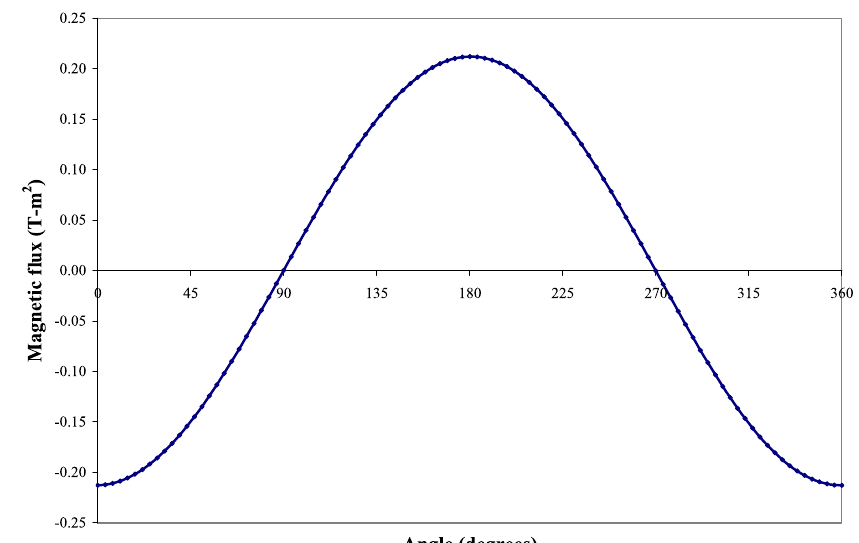
FIG. 8. (Color) Total magnetic flux through the patches vs rotation